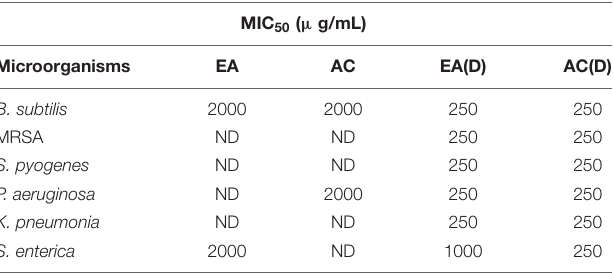
TABLE 2 | MIC 50 of the G. edulis sequential and direct extracts against all tested